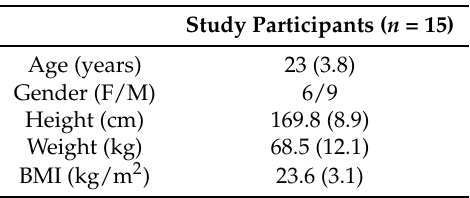
Table 1. Participant characteristics.